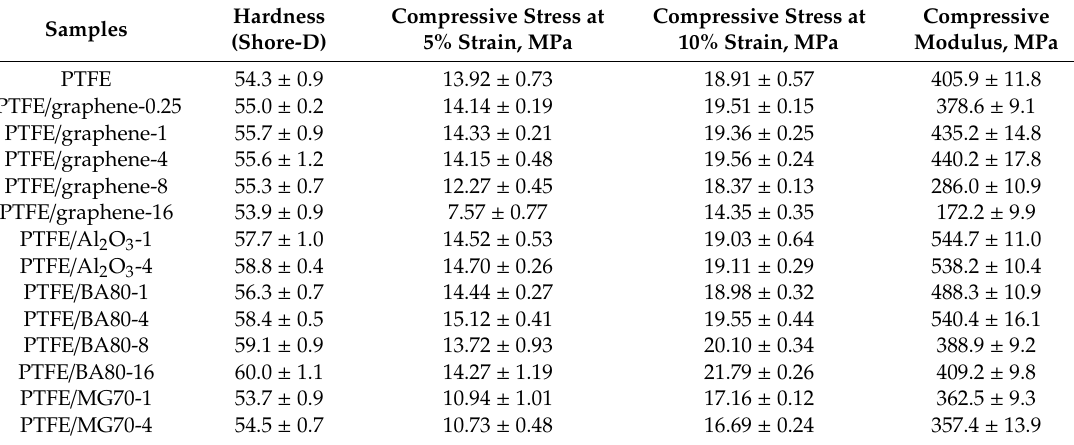
Table 4. Average Shore-D hardness, compressive stress at 5% and 10% strain and average compressive modulus of the sintered